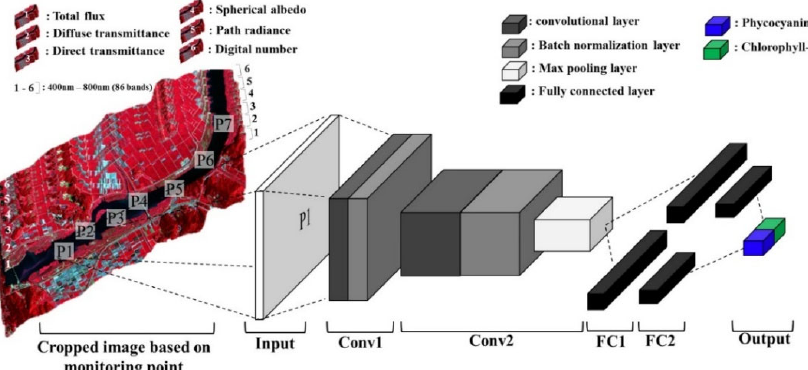
Figure 2. Convolutional neural network architecture for phytoplankton pigment estimation [12].